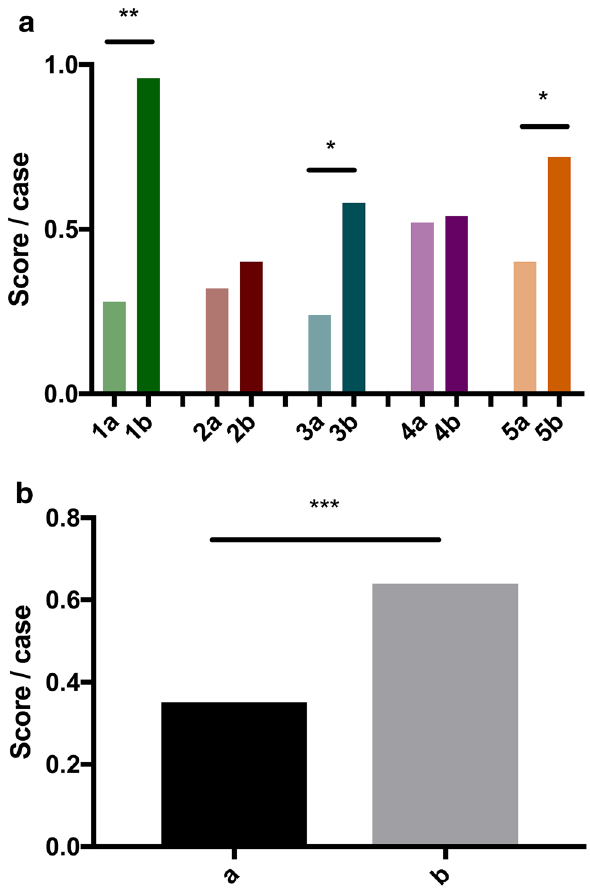
Figure 4. ( a ) Weighted mean score per case of each resident 1–5 without SPS (a) and with SPS (b). ( b ) Mean weighted score/case without SPS (a) and with SPS (b).